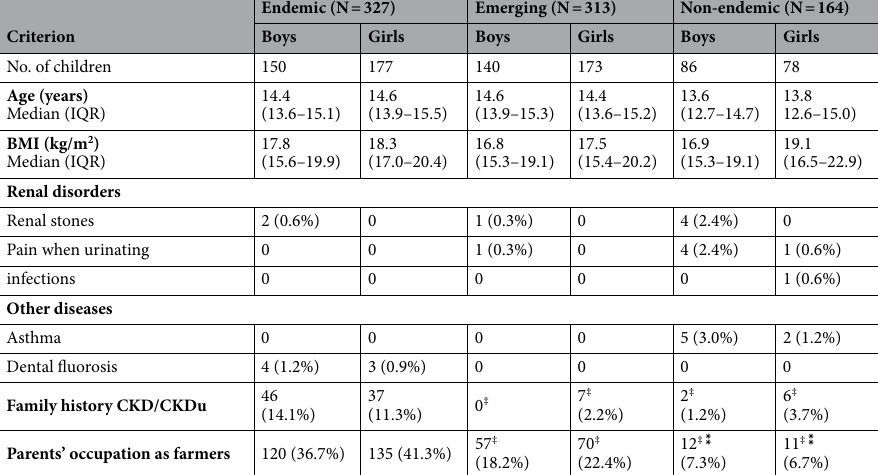
Table 1. Sociodemographic and clinical characteristics of the study participants. The occurrence of renal disorders, other diseases, family history of chronic kidney disease of uncertain etiology (CKDu) and parents’ involvement in farming is given as the number of children and as a percentage of the total size of respective group. Statistical significance between proportions is expressed for boys and girls in CKDu emerging and non-endemic areas compared to their counterparts from other groups according to Chi-squared test; ‡ denotes comparison with endemic group ( p < 0.05) and ⁑ denotes comparison with emerging group ( p < 0.05). BMI- body mass index, and IQR- inter quartile range. Age is given to the date of sample